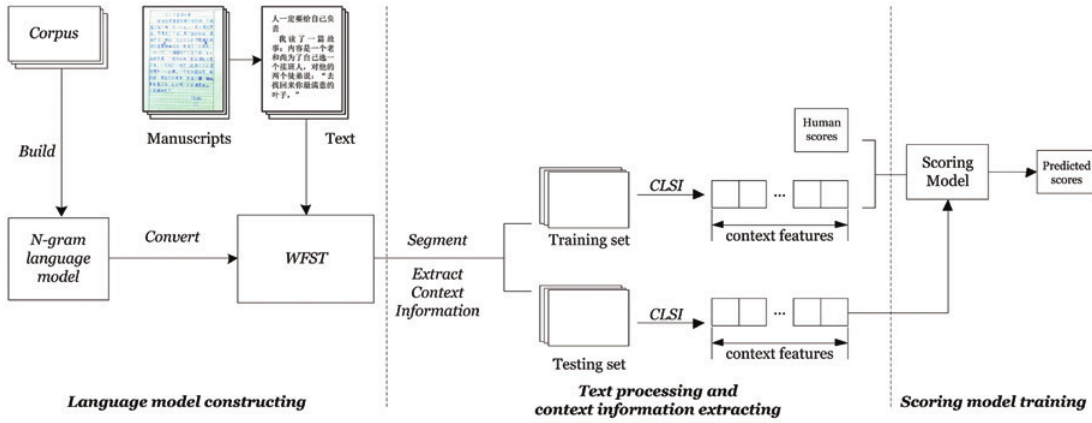
Figure 3: The Framework of Automated Chinese Essay Scoring Using